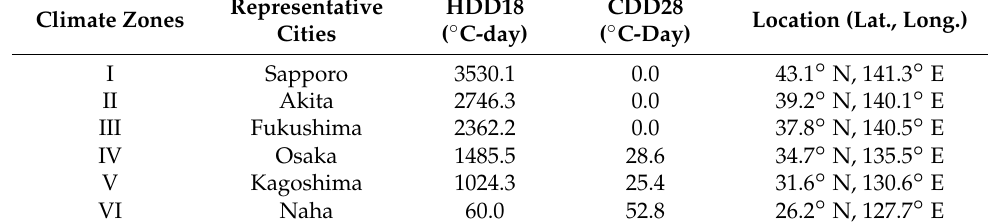
Table 2. Details of Japan’s six climatic regions [12].